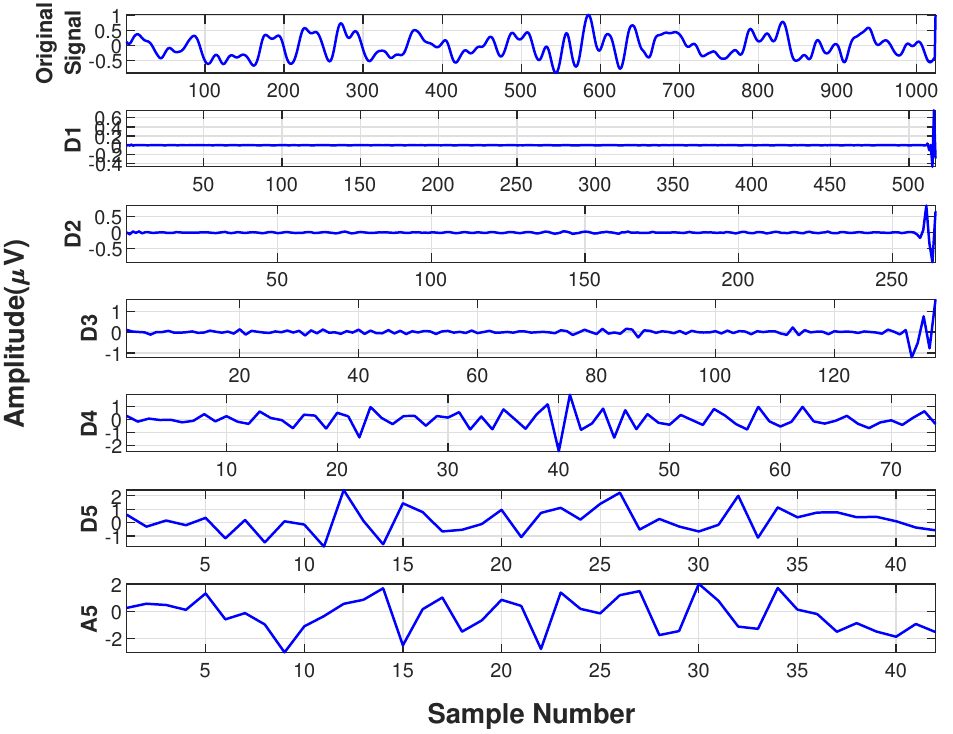
Figure 5. Subbands obtained after wavelet decomposition of a 2-second epoch of CAP Phase-B. Hjorth Parameters: Three Hjorth parameters named activity, mobility and complexity are utilized in our study along with wavelet entropy for feature extraction which are extensively used in applications related to EEG signals. These parameters mainly